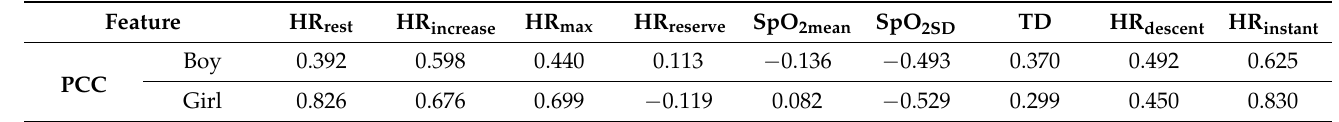
Table 3. Values of the Pearson correlation coefficient between teenagers’ initial features and their fitness levels.